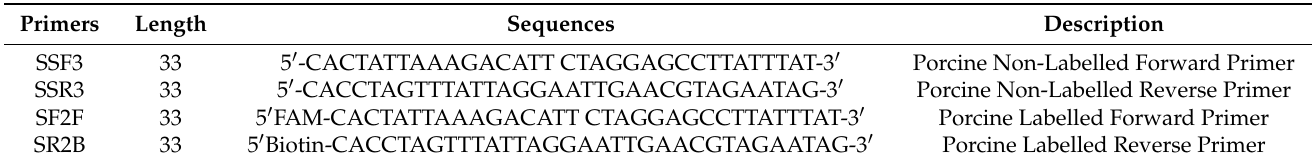
Table 2. Oligonucleotide sequences of the primers used in this